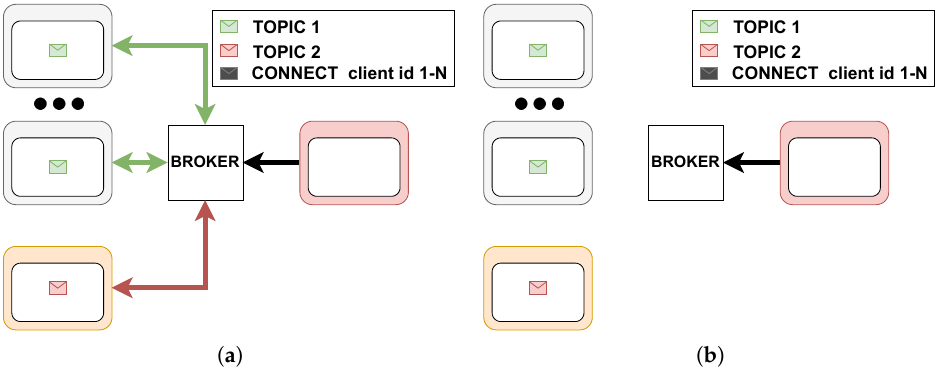
Figure 11. MQTT-SN disconnect wave scheme. ( a ) MQTT-SN disconnect wave, implementation of the attack. ( b ) MQTT-SN disconnect wave, result of the